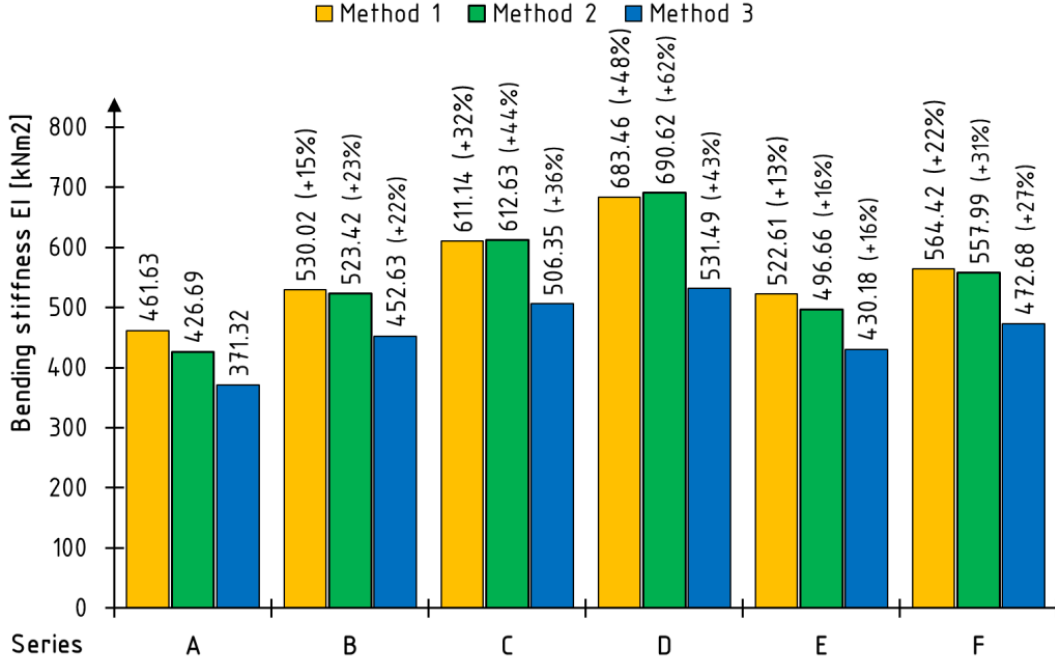
Figure 9. Average values of bending stiffness EI .